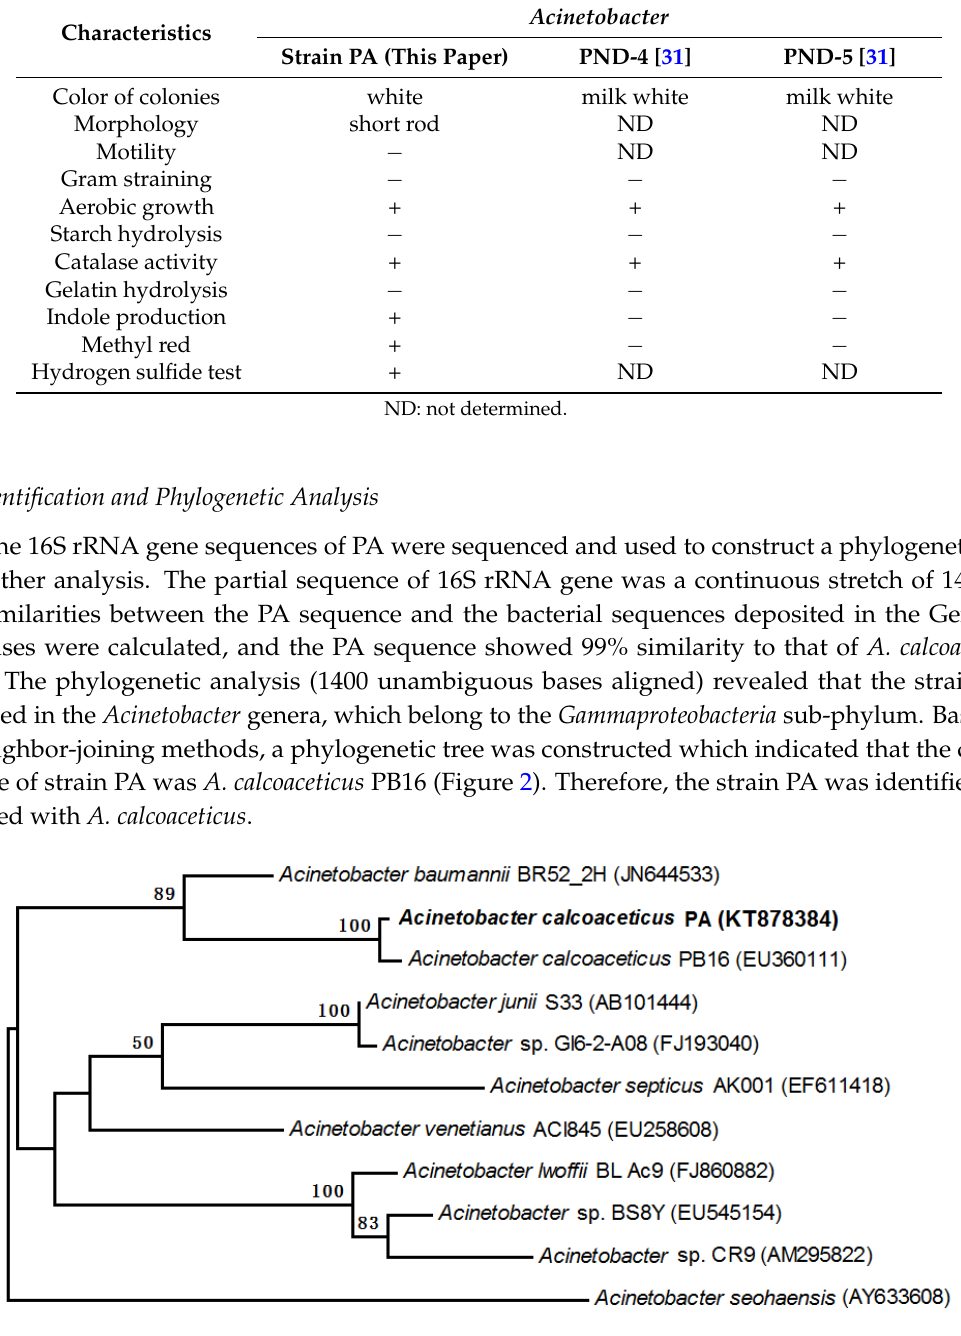
Table 1. Morphological and biochemical characteristics among Acinetobacter strains.